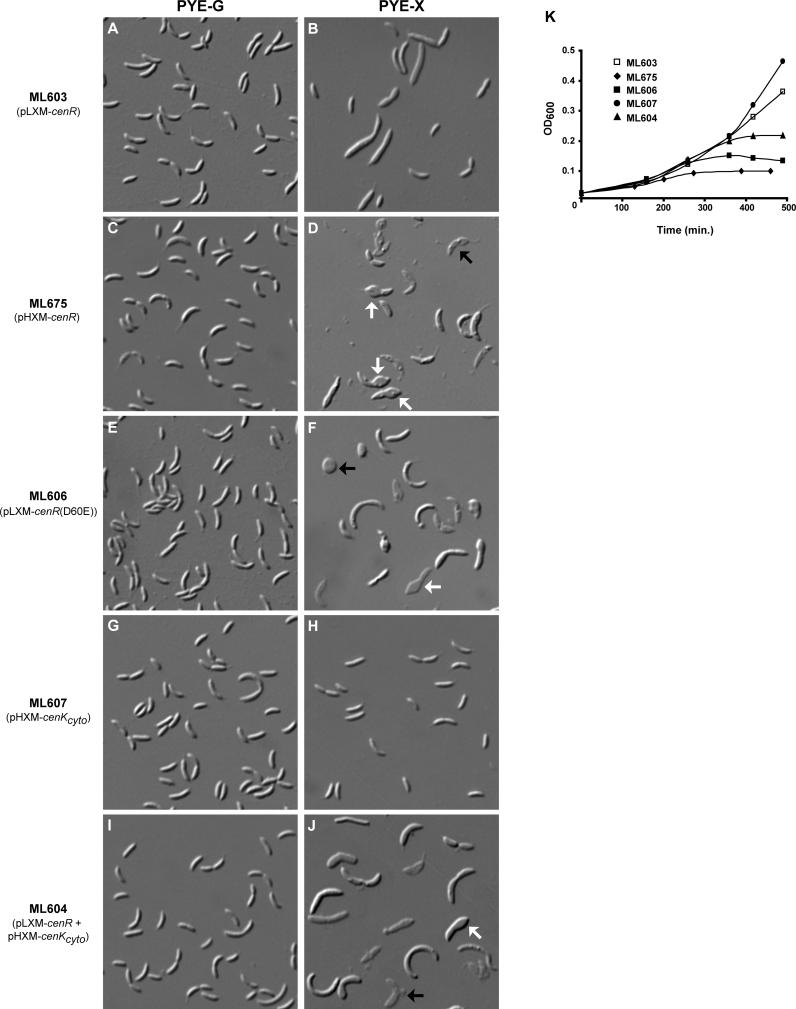
Constitutive Activation of the CenK–CenR Pathway Leads to Dramatic Changes in Cell Morphology, Cell Lysis, and DeathImages are shown for strains grown overnight in PYE plus glucose and then diluted back to early log phase and grown for 5 h in PYE plus glucose (A, C, E, G, and I) or xylose (B, D, F, H, and J). In all panels, white arrows indicate cells with asymmetric bloating and black arrows indicate lysed cells.(A and B) ML603 (CB15N + pLXM-cenR + pJS71) expresses CenR alone from a low-copy vector.(C and D) ML675 (CB15N + pHXM-cenR) expresses CenR alone from a high-copy vector.(E and F) ML606 (CB15N + pLXM-cenR[D60E]) expresses, from a low-copy vector, a mutant of CenR that mimics constitutive phosphorylation.(G and H) ML607 (CB15N + pMR20 + pHXM-cenK
cyto) expresses CenKcyto alone from a high-copy vector.(I and J) ML604 (CB15N + pLXM-cenR + pHXM-cenK
cyto) expresses both CenR and CenKcyto, from low- and high-copy plasmids, respectively.(K) Growth curve for all strains from (A–J) grown in PYE supplemented with xylose [64,65].